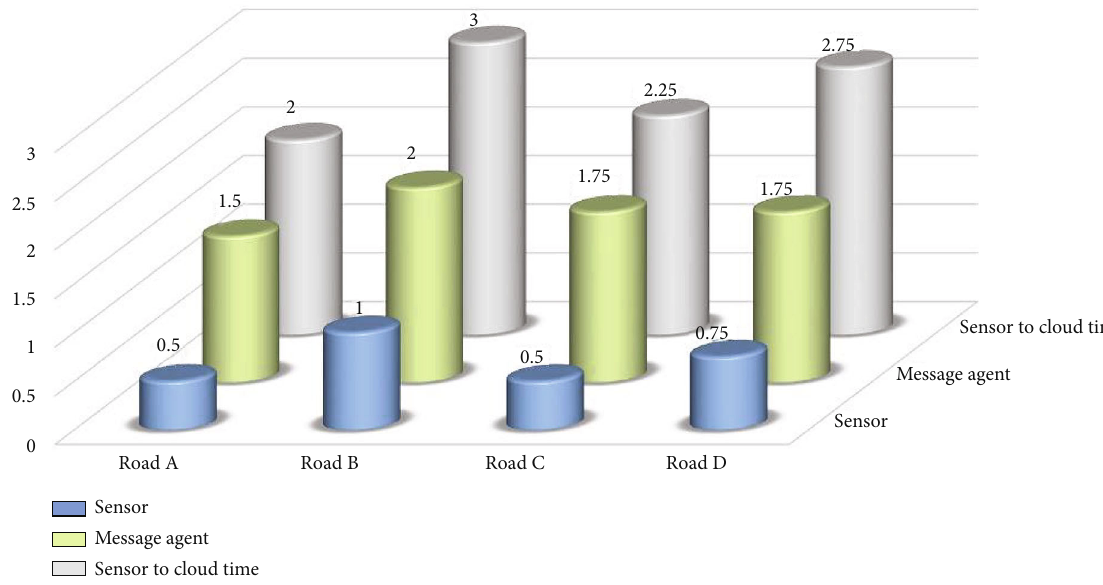
Figure 5: Sync timing of communication messages between sensors, message agents, and